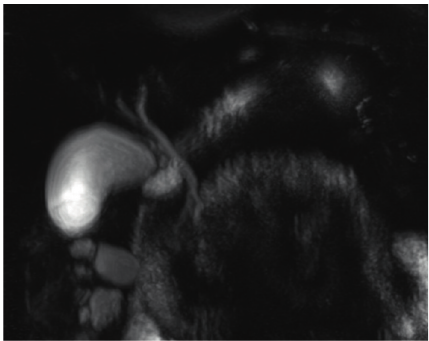
Figure 1: MRCP—choledocholithiasis; no signs of common bile duct dilation and normal intrahepatic bile